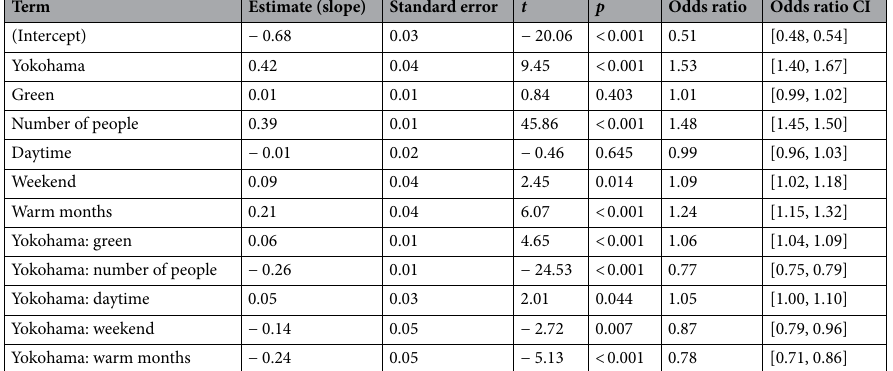
Table 5. The association of green vegetation with HFE.